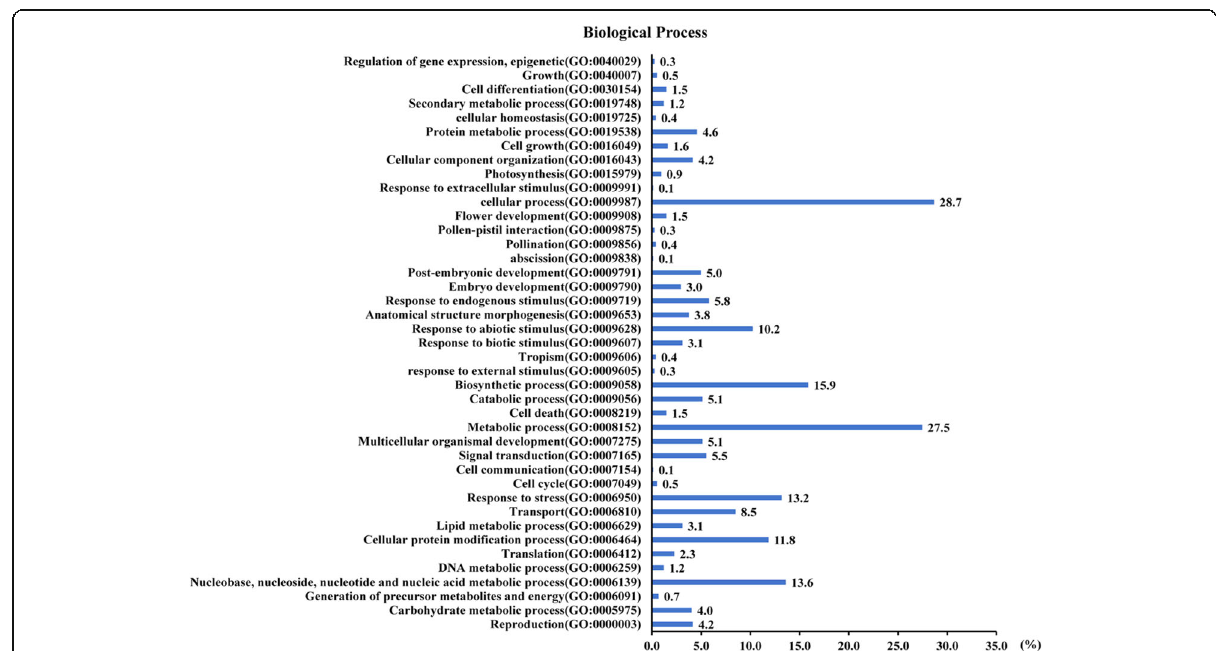
Fig. 2 Functional classification based on GO-biological process for 743 identified candidate rice genes driven by